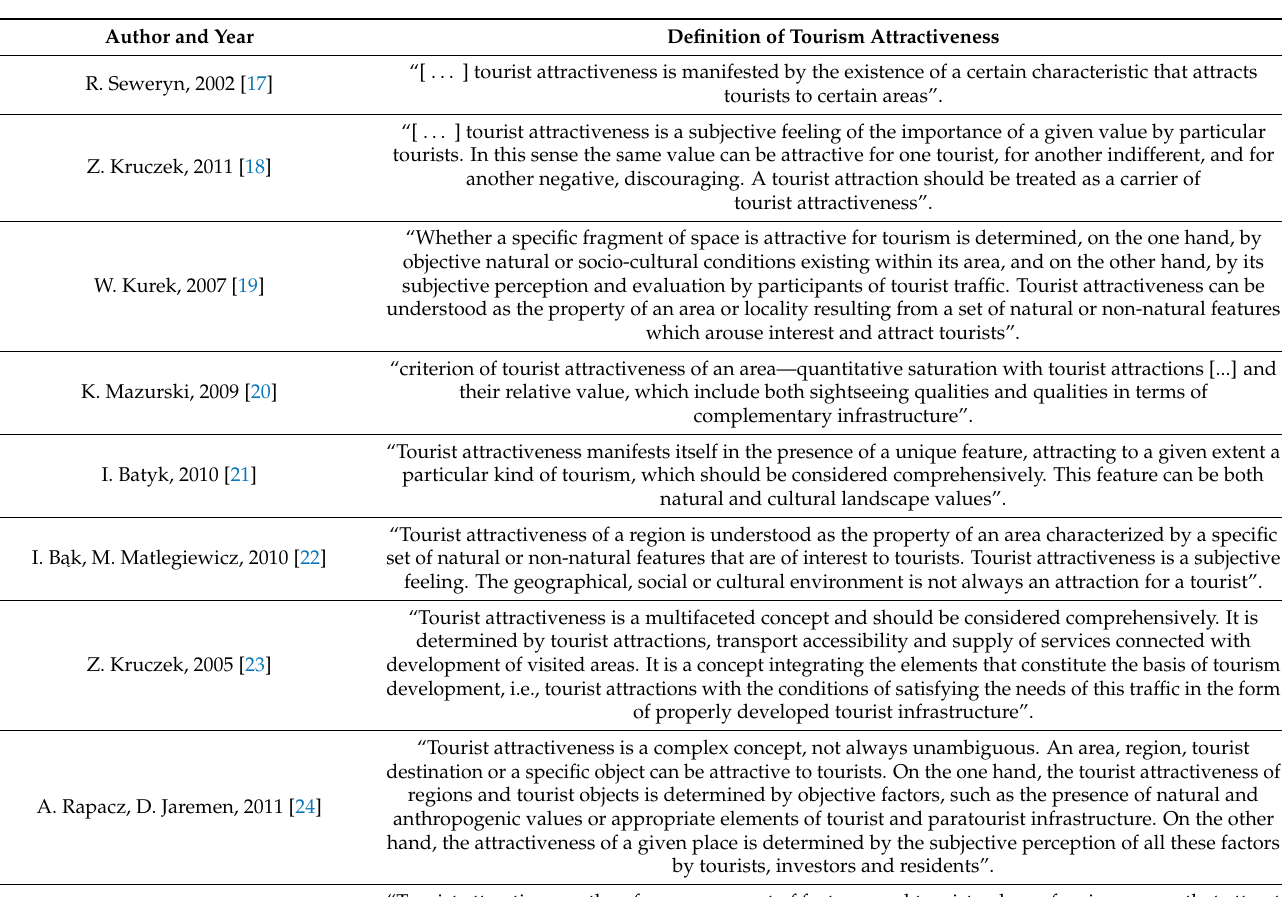
Table 1. Definitions of tourism attractiveness according to selected